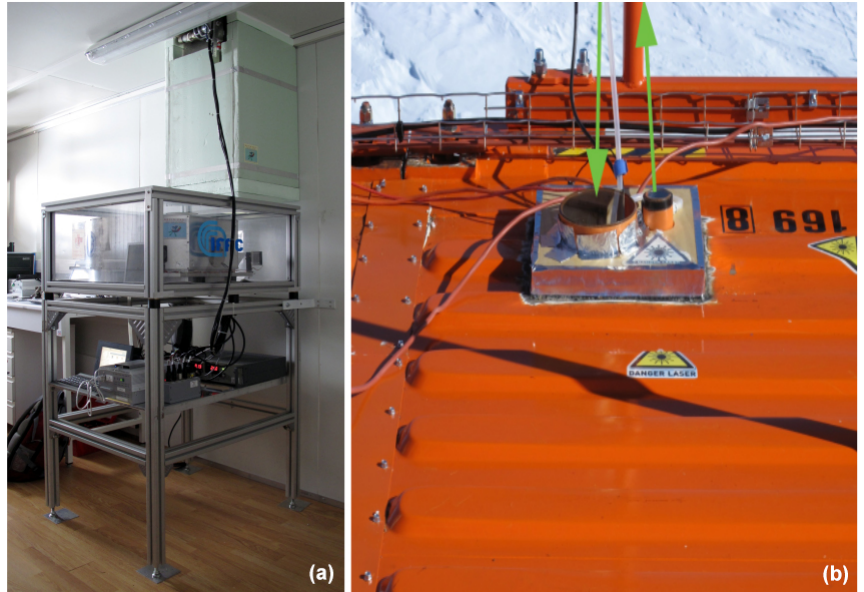
Figure 1. (a) REFIR-PAD Fourier transform spectroradiometer inside the PHYSICS shelter with the 1.5m chimney connecting the instru- ment with the outside. (b) Output windows of the tropospheric lidar on the roof of the shelter.